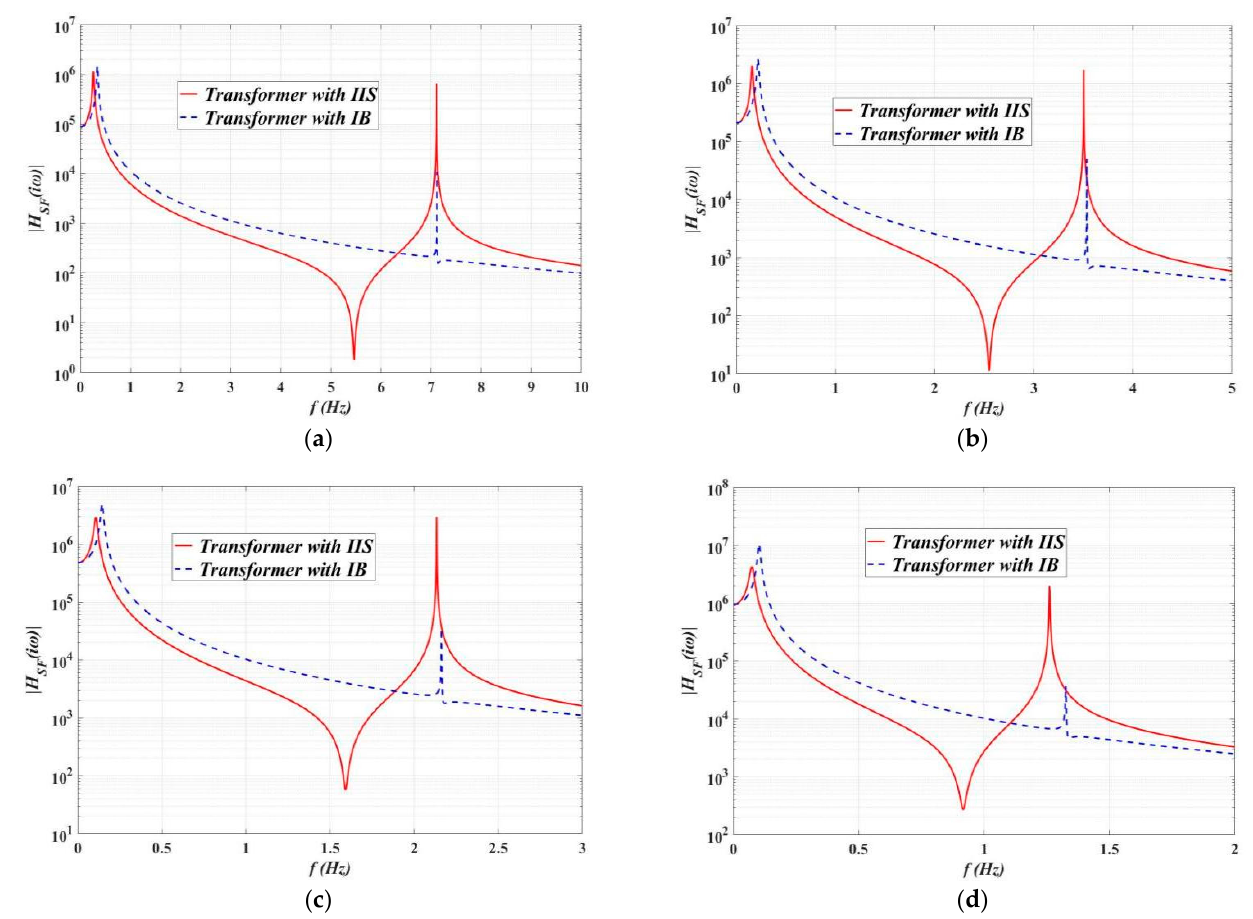
Figure 15. Transfer function curves of base shear force: ( a ) HB–1 ; ( b ) HB–2 ; ( c ) LB–1 ; ( d ) LB–2 .